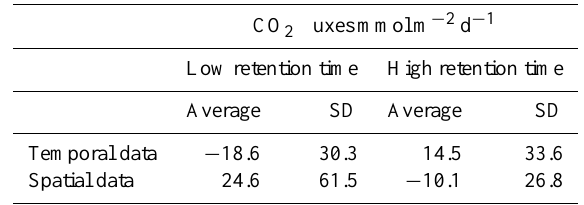
Table 4. Comparison between CO 2 fluxes (mmolm − 2 d − 1 ) calcu- lated during periods of low retention time and high retention time. Positive fluxes denote net gas fluxes from the lake to the atmo- sphere. Statistical analyses showed significant differences between temporal and spatial data and between low and high retention times ( t test, p <0.05). ∗ We considered data for low retention and high retention time as values less than 25 days and more than 38 days, respectively. The average CO 2 fluxes during periods of intermediate retention time were close to 0 (0.5mmolm − 2 d − 1 )